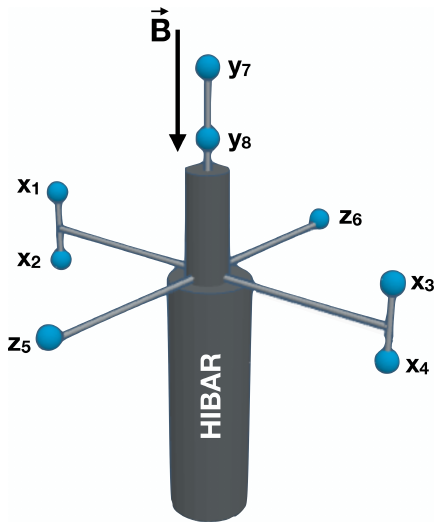
Figure 1. Diagram of the HIBAR rocket showing approximate an- tenna orientations with respect to the background magnetic field (note that the labeling of the probes has no connection to Cartesian